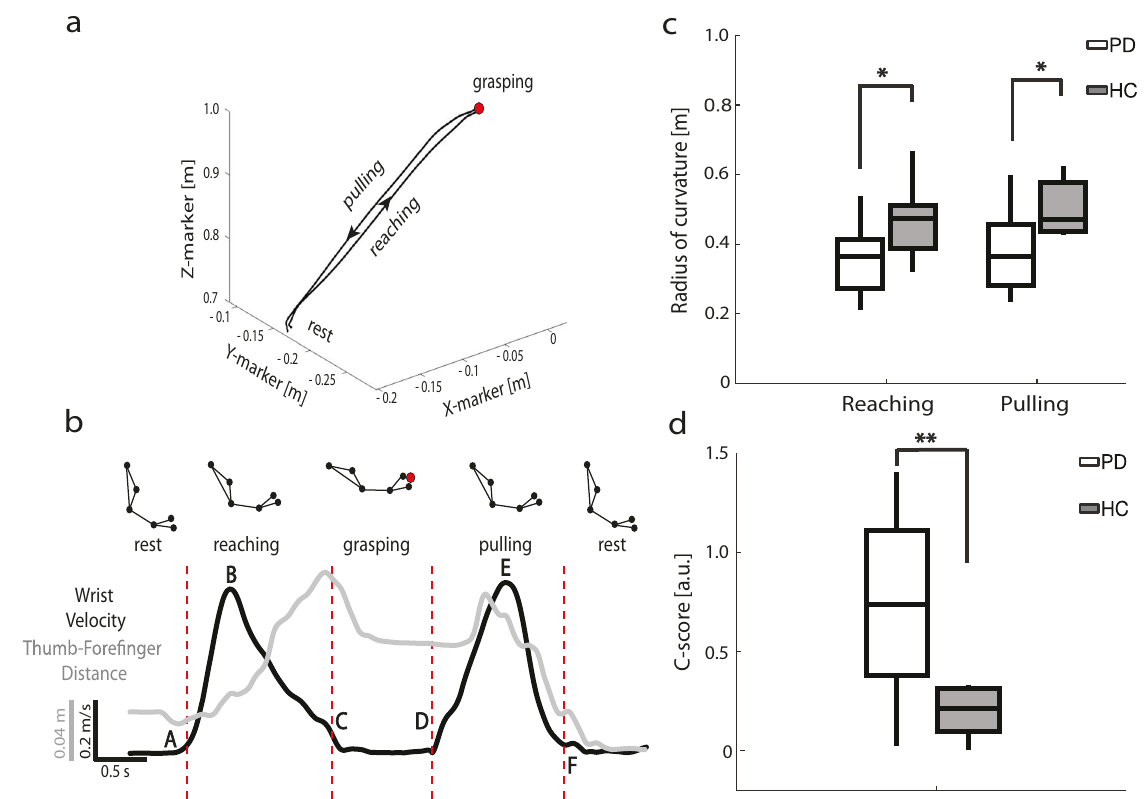
Fig. 1 Kinematics measurements of parkinsonian patients (PD) and healthy controls (HC). a Example of the trajectory of one reach-to- grasp trial for patient wue02. The black arrows indicate the direction of the movement from the start of the reaching phase to the end of the pulling phase. X-marker: anterior – posterior coordinate of the marker; Y-marker: medio-lateral coordinate of the marker; Z-marker: vertical coordinate of the marker. b Task phases identi fi cation for patient wue02. Reach-to-grasp phases were de fi ned according to the wrist marker absolute velocity pro fi le (black line). The thumb-fore fi nger distance is plotted in gray. The letters A – F indicate the relevant timestamps during the reach-to-grasp task: A, movement onset; B, velocity peak of the reaching phase; C, approach to target; D, movement onset; E, velocity peak of the pulling phase; F, comeback to start position. The red dashed vertical lines identify the phases. Markers were placed on the acromion, the bicep muscle, the lateral epicondyle of the humerus, the ulnar styloid, the distal phalange dorsal head of the index, and the tip of the thumb. See also Supplementary Fig. 1. c Radius of the curvature during the reaching and pulling phases. d Coordination C-score. Boxplots are drawn between the 25th and the 75th percentiles, with a horizontal line indicating the median. The whiskers extended above and below to the most extreme data points within 1.5 times the interquartile range. Asterisks denote the statistical signi fi cance * p < 0.05, ** p < 0.01, and *** p < 0.001 of the Mann – Whitney U-test. See also Supplementary Figs. 1 –